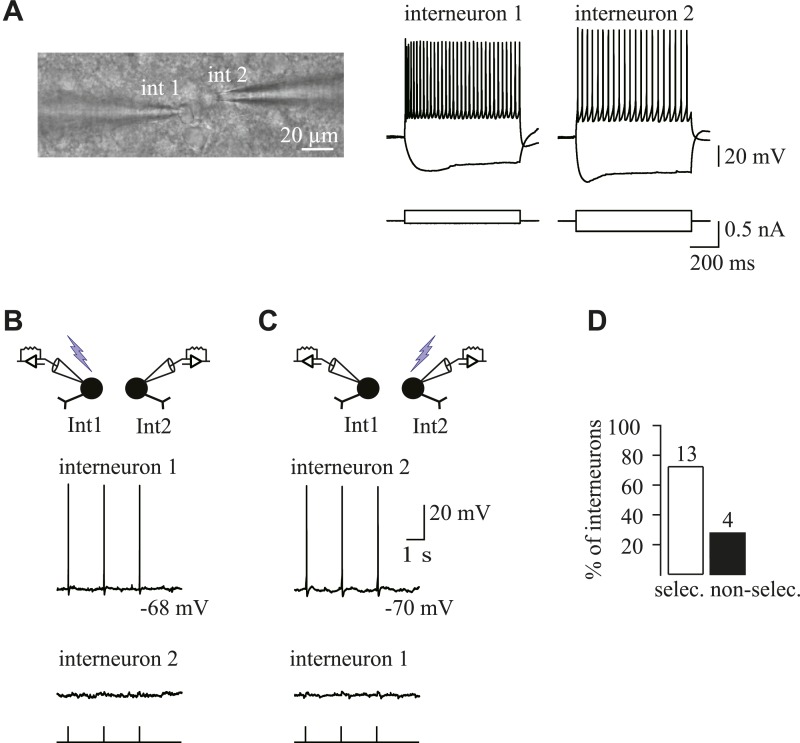
Spatial selectivity of holographic photostimulation of targeted Venus+ interneurons.(A) DIC image of a simultaneous patch-clamp recording of two photostimulated Venus+ interneurons (left; fluorescence not shown). Note the close proximity of the two cell somata. Current-clamp recordings obtained for each recorded interneuron in response to current injections (right). (B, C) Simultaneous current-clamp recordings in response to single-cell photostimulation of either interneuron 1 (B) or interneuron 2 (C). Note that the laser pulse elicits a reproducible action potential in the target interneuron (top traces), but not in the nearby interneuron (bottom traces). (D) Histogram of the percentage of interneurons for which the photostimulation was selective when the illumination spot was moved onto the soma of the other interneuron. Note that the selectivity is attained in 76% of the cases. It is noteworthy that simultaneous recordings were performed between interneurons located at different planes and at very short intersomatic distances (mean intersomatic distance measured between the center of somata: 21.8 ± 2.0 µm, n = 17 simultaneous recordings). In addition, the time pulse used to test the spatial selectivity to generate action potentials in simultaneous recordings of two interneurons was always at least the minimal time needed to elicit an action potential in the nearby non-photostimulated interneuron.